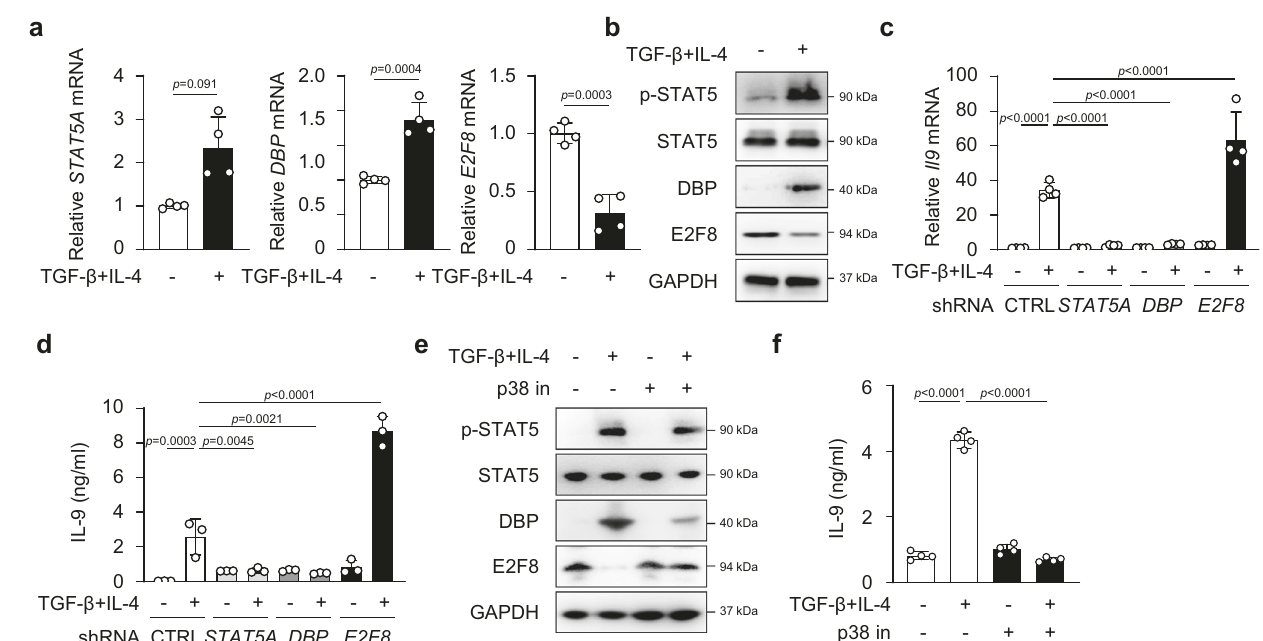
Fig. 5 | The functions of DBP and E2F8 in human TH9 differentiation. a RT-PCR analysis and b Western blotting of STAT5, DBP and E2F8 in human CD4 + T cells cultured with TGF- β plus IL-4 for 5 days. c Expression of Il9 mRNA after 3 days and d ELISA of IL-9 after 5 days in human CD4 + T cells transfected with STAT5A , DBP or E2F8 speci fi c siRNA, followed by stimulation with TGF- β plus IL-4. e Western blot- ting of STAT5, DBP and E2F8 and f IL-9 protein were measured by ELISA in human